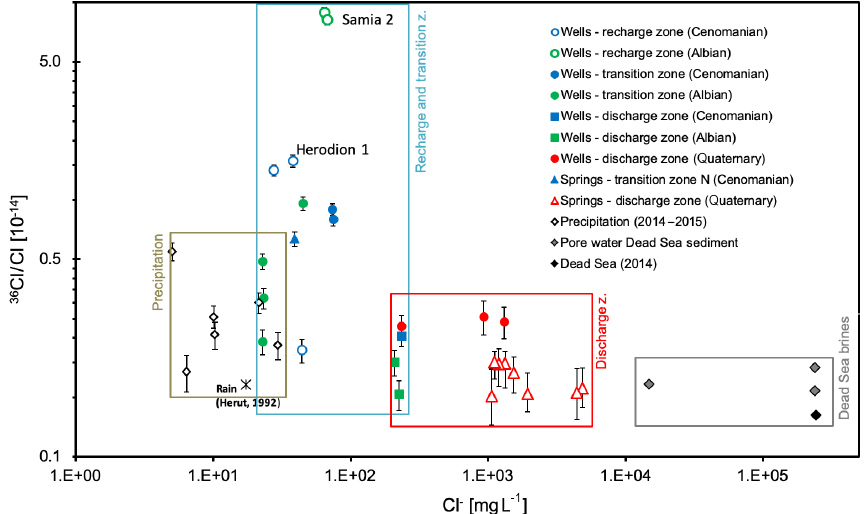
Figure 3. Results of 36 Cl / Cl vs. chloride concentrations in the investigation area in log scale.